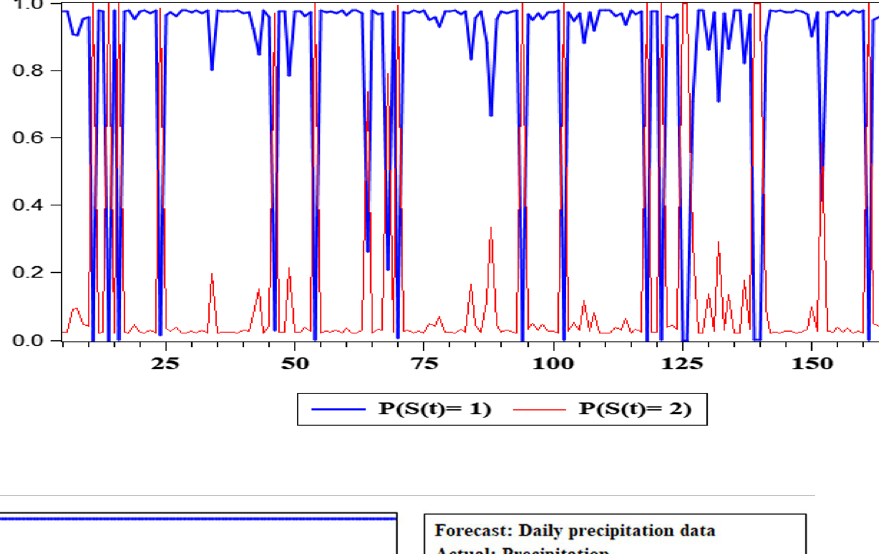
Fig. 2 Markov switching smoothed regime probabilities for rainfall original data